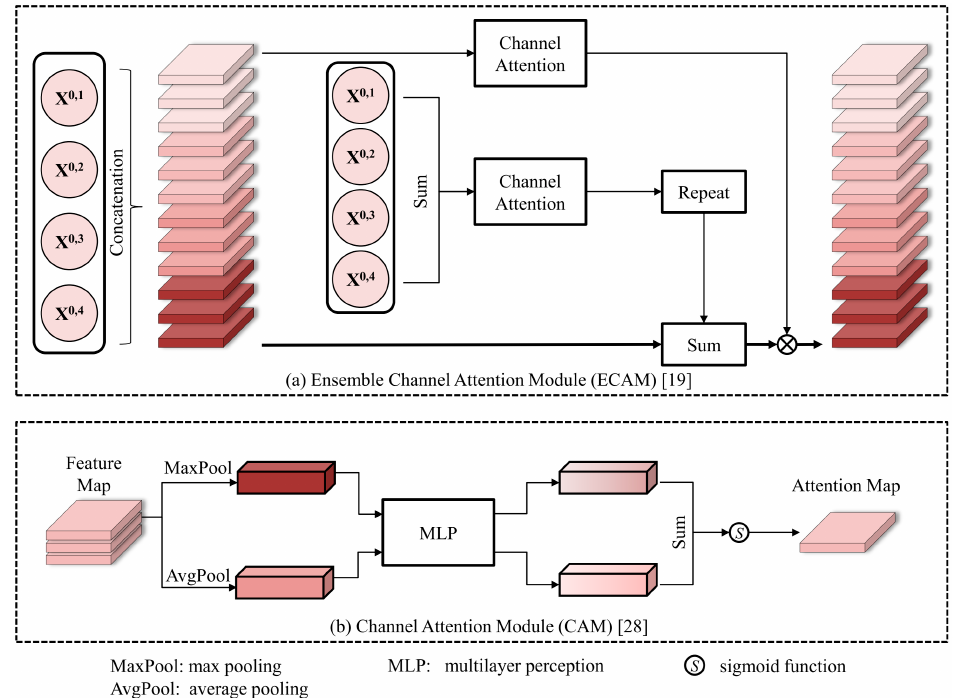
Figure 5. Attention module used in DSNUNet at the decoder end. ( a ) is the ECAM module, which is a plain combination of the channel attention mechanism and the ensemble method; ( b ) is the channel attention module (CAM), modeling the dependencies between channels. In CAM, AvgPool and MaxPool denote average pooling and max pooling operations respectively, MLP denotes a multilayer